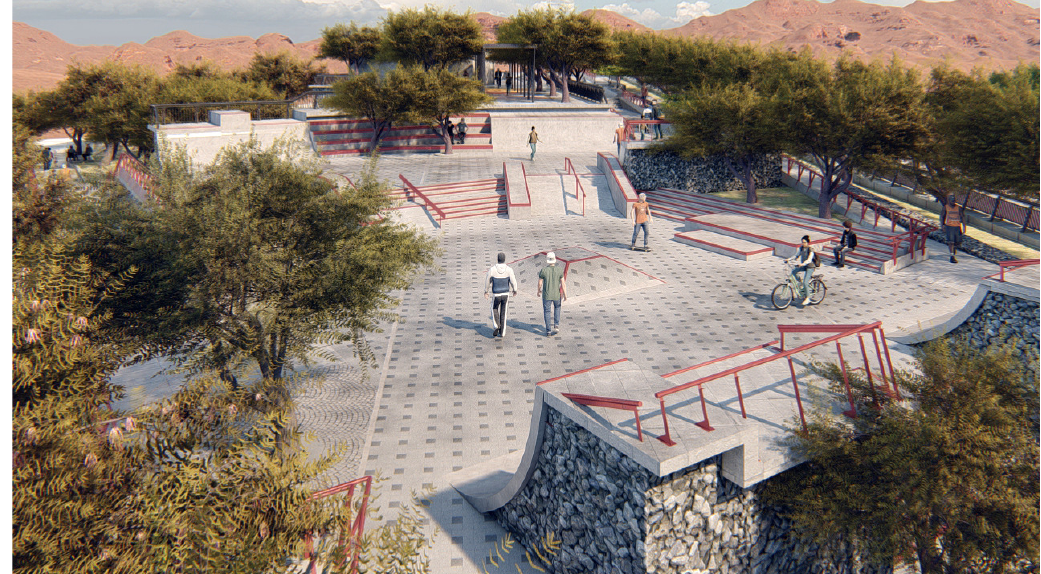
Figure 2. Work‐in‐progress visualisation of the Slope Sports Square. Source: Courtesy of Co‐Diseño Urbano